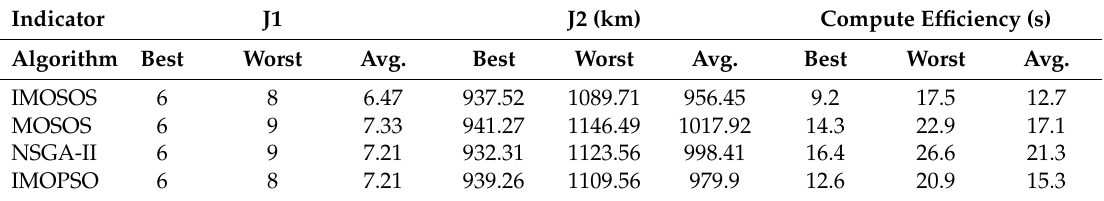
Table 7. Statistical results of Monte-Carlo simulations on Scenario 2.